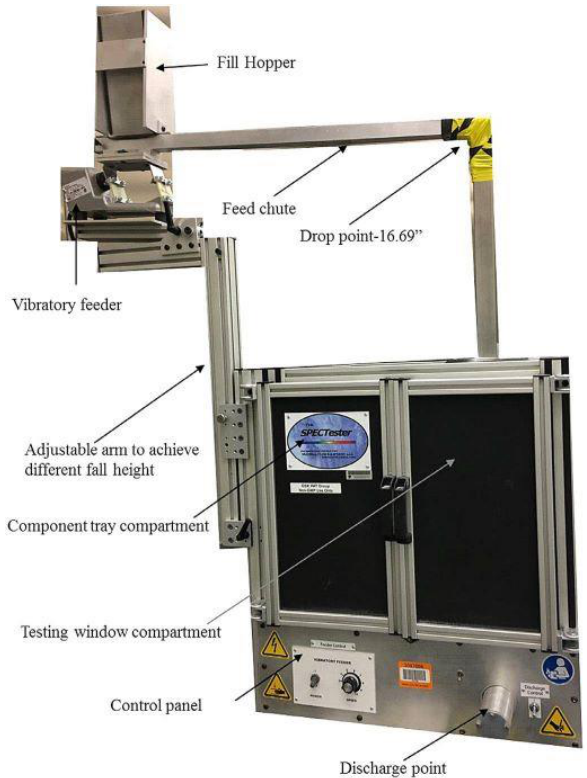
Figure 3. Custom vibratory tester for the simulation of different segregation mechanisms as de- scribed by Desai et al., adapted with permission from [39]; published by Elsevier, 2020. by Desai et al., adapted with permission from [39]; published by Elsevier,